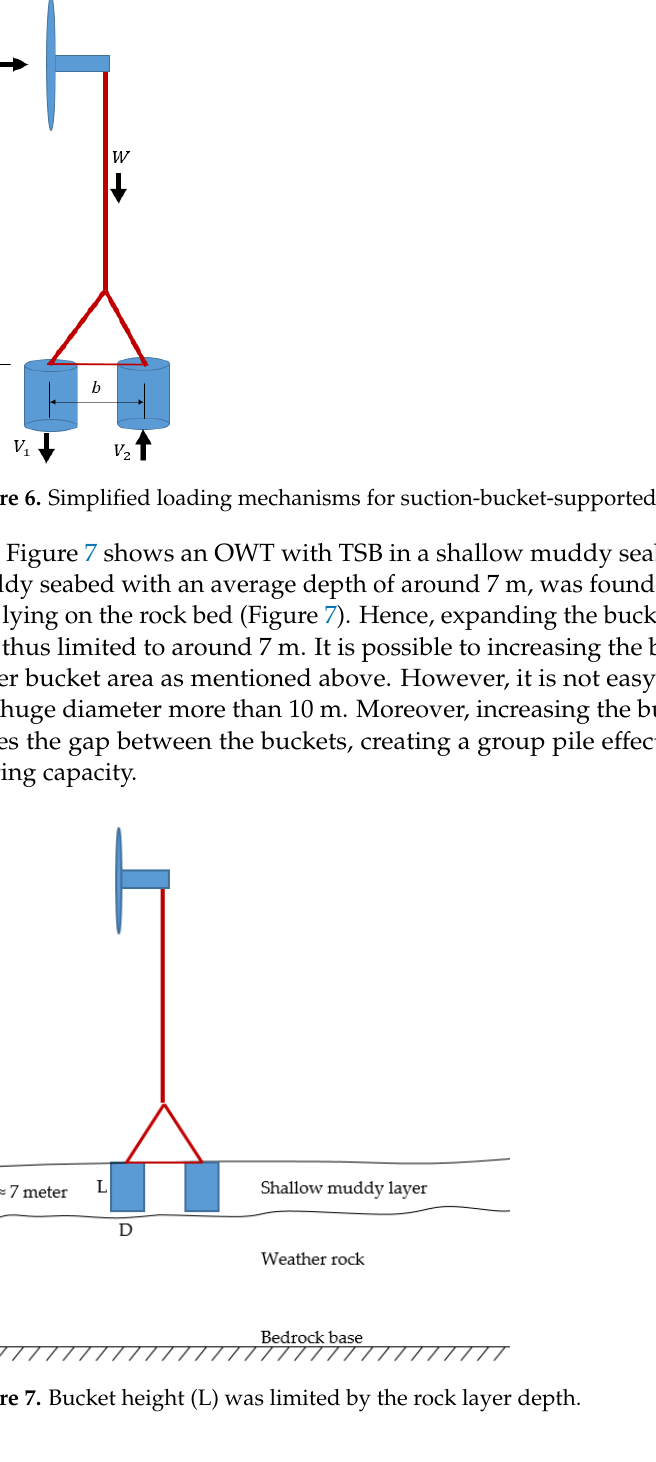
Figure 7. Bucket height (L) was limited by the rock layer depth.